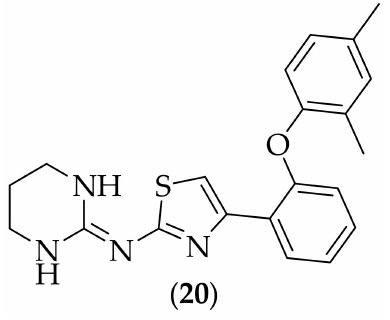
Figure 11. Structure of abafungin ( 20